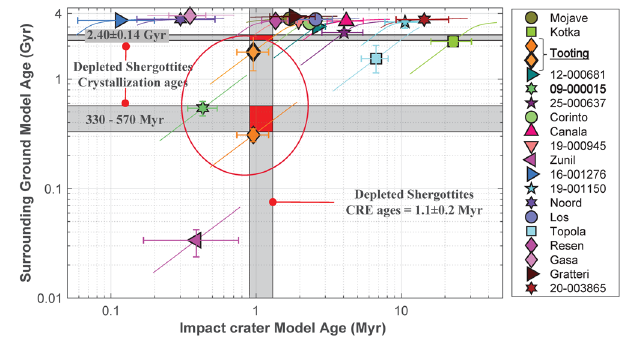
Fig. 3 Model ages of the crater candidates ages and their host units. Vertical and horizontal grey bands correspond respectively to the range of CRE ages and the crystallization ages 3,4 of depleted shergottites launched 1.1 Myr ago including NWA 7635 (2.40 ± 0.14 Gyr). Error bars are generated based on crater counts. Oblique colour lines illustrate the expected displacement in time if different cratering rates are considered (range of a factor of 2 around the reference impact fl ux 21 ). The red circle outlines the two craters whose model age of their host unit is compatible with the range of crystallization age of depleted shergottites launched 1.1 Myr ago: Tooting and 09-000015. Note that two ages are reported for Tooting, one (308 ± 41 Myr) corresponding to immediate surrounding (thin outline), and the other (1 : 77 þ 0 : 69 (cid:2) Gyr) accounting for large craters around 0 : 58 Tooting and partially fi lled-up by more recent lavas (thick outline). Craters in the legend are sorted by size (Supplementary Table